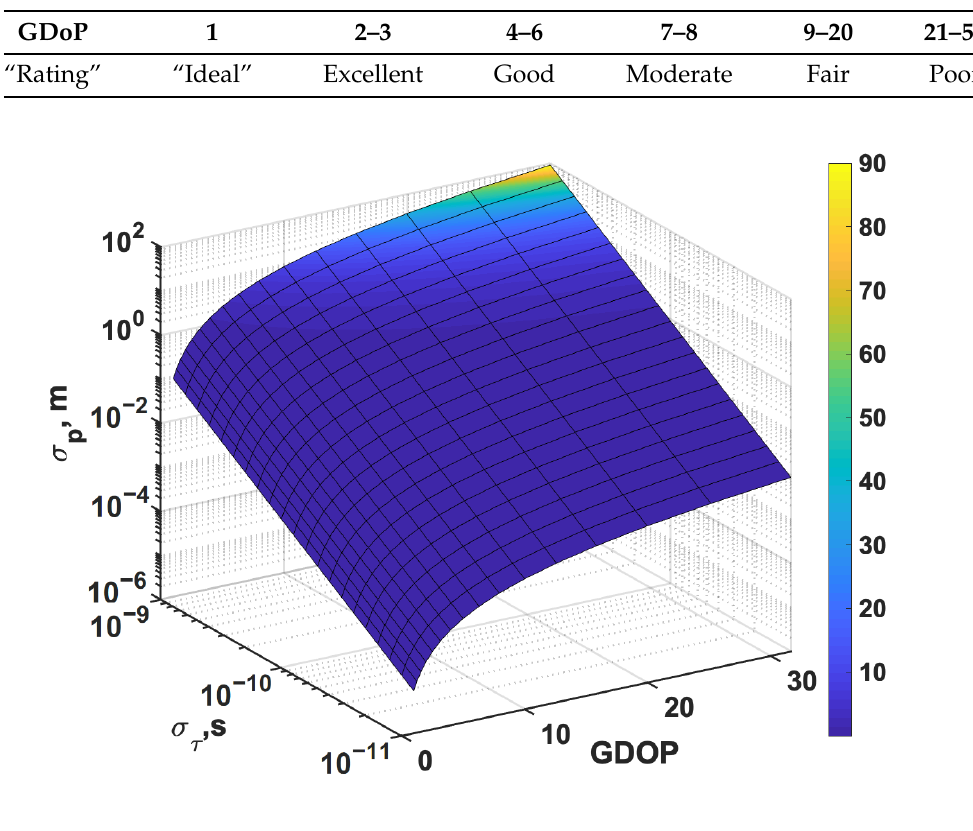
Figure 5. Performance manifold defined by Equation (20) as a function of ranging precision and GDoP for N =